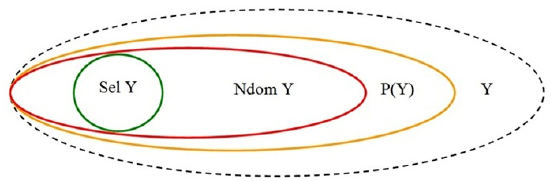
Figure 5. The relations of sets of vector estimates: the largest set is the set of possible estimates Y, and the smallest—a set of selected vectors, Sel Y.